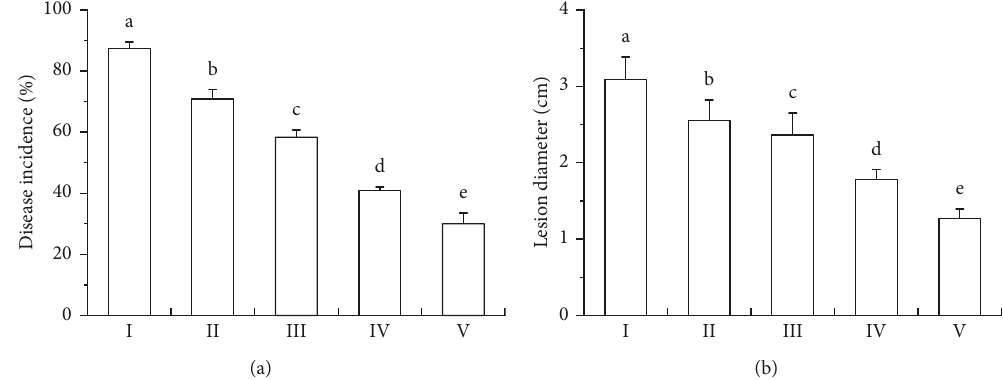
Figure 2: The effect of P. fluorescens concentration on biocontrol efficacy: I, SDW; II, 1 10 9 CFU/mL. Columns with different lowercase letters within the same panel are significantly different at the P 10 8 CFU/mL; V, 1 × level by Duncan’s multiple range test.